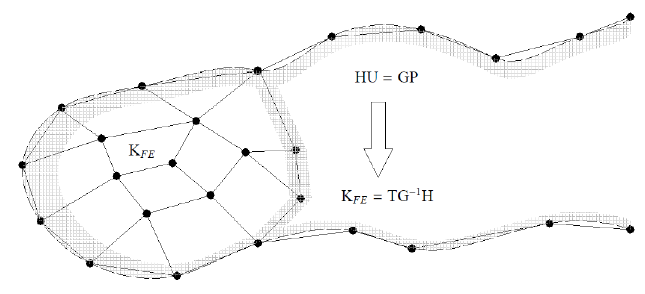
Figure 4. Coupling of finite element (FE) with a boundary element (BE)